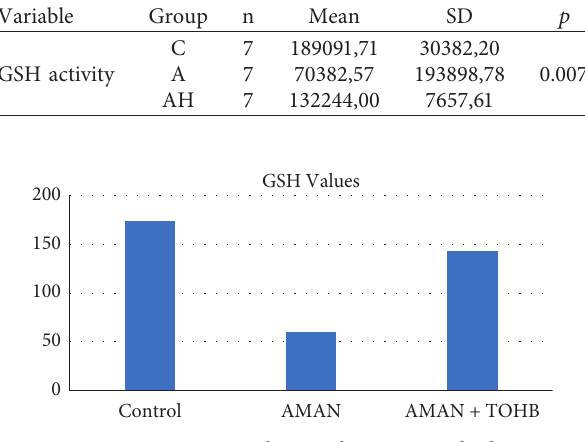
Figure 4: GSH analysis with ELISA method. Table 5: Descriptive data of IL-1 β expression in the rabbit model.